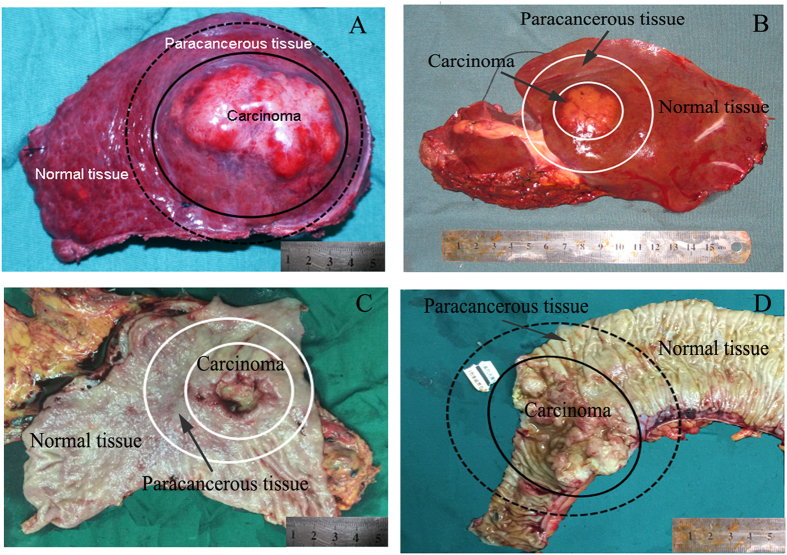
Representative images showing carcinoma, paracancerous tissue and paired normal tissue in liver (A,B), stomach (C) and colon (D). Paracancerous tissue was defined as the tissue less than 2 cm away from the tumor edge. Paired normal tissue was defined as the tissue more than 2 cm away from the tumor edge.